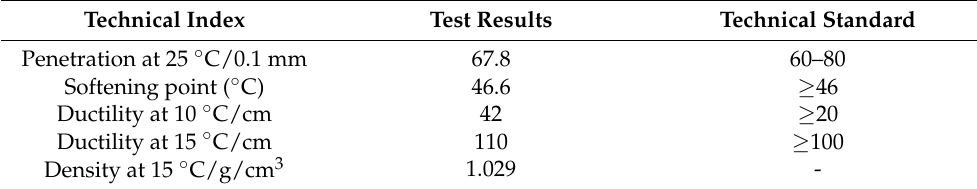
Table 1. Test results of neat asphalt.